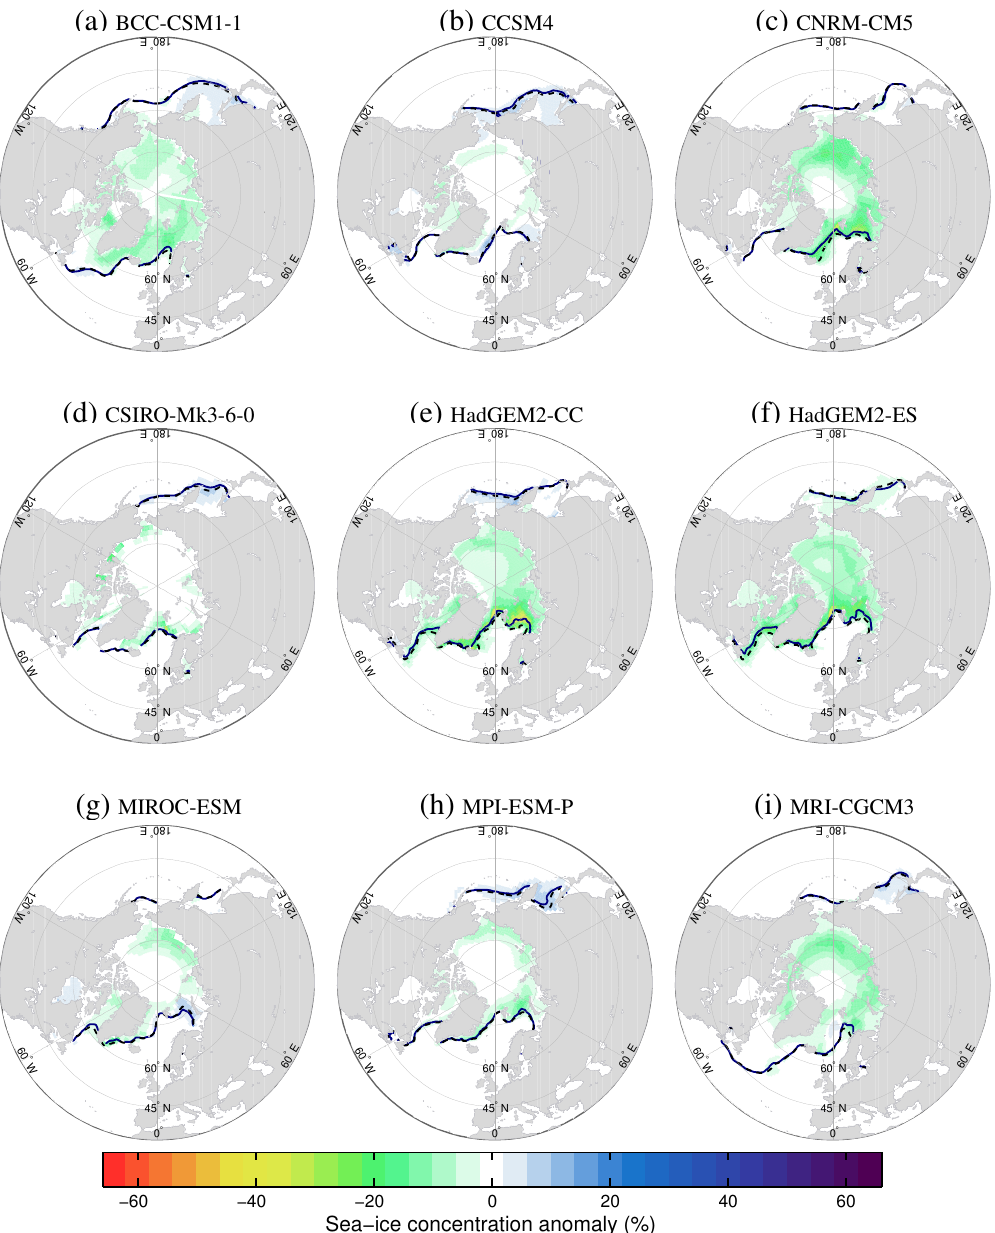
Figure A1. Mean MH annual sea ice concentration anomalies (in %, with respect to the PI reference period) and location of the ice edge for 6ka (solid lines) and for the PI period (dashed lines), defined as 15% concentration